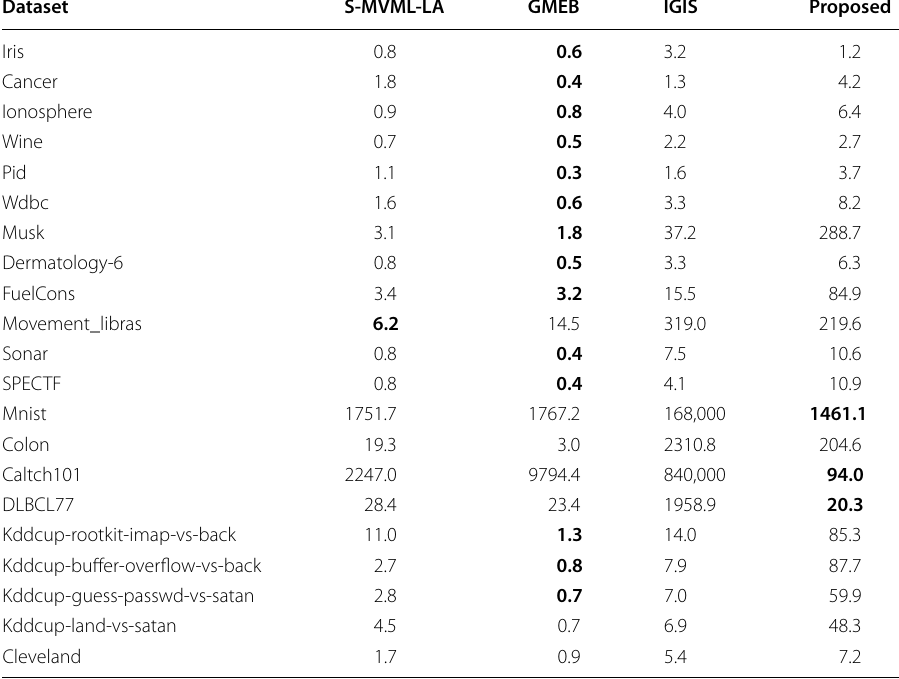
The numbers in bold are the best accuracies achieved on the dataset